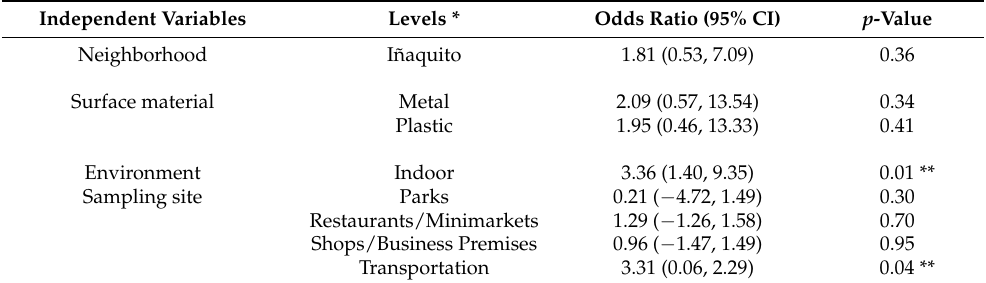
Table 1. Results of the logistic regression models for the effects of different parameters on the presence of SARS-CoV-2 RNA in environmental samples. Independent variables “environment—indoor” and “sampling site—transportation” are significantly associated with positivity rates in our